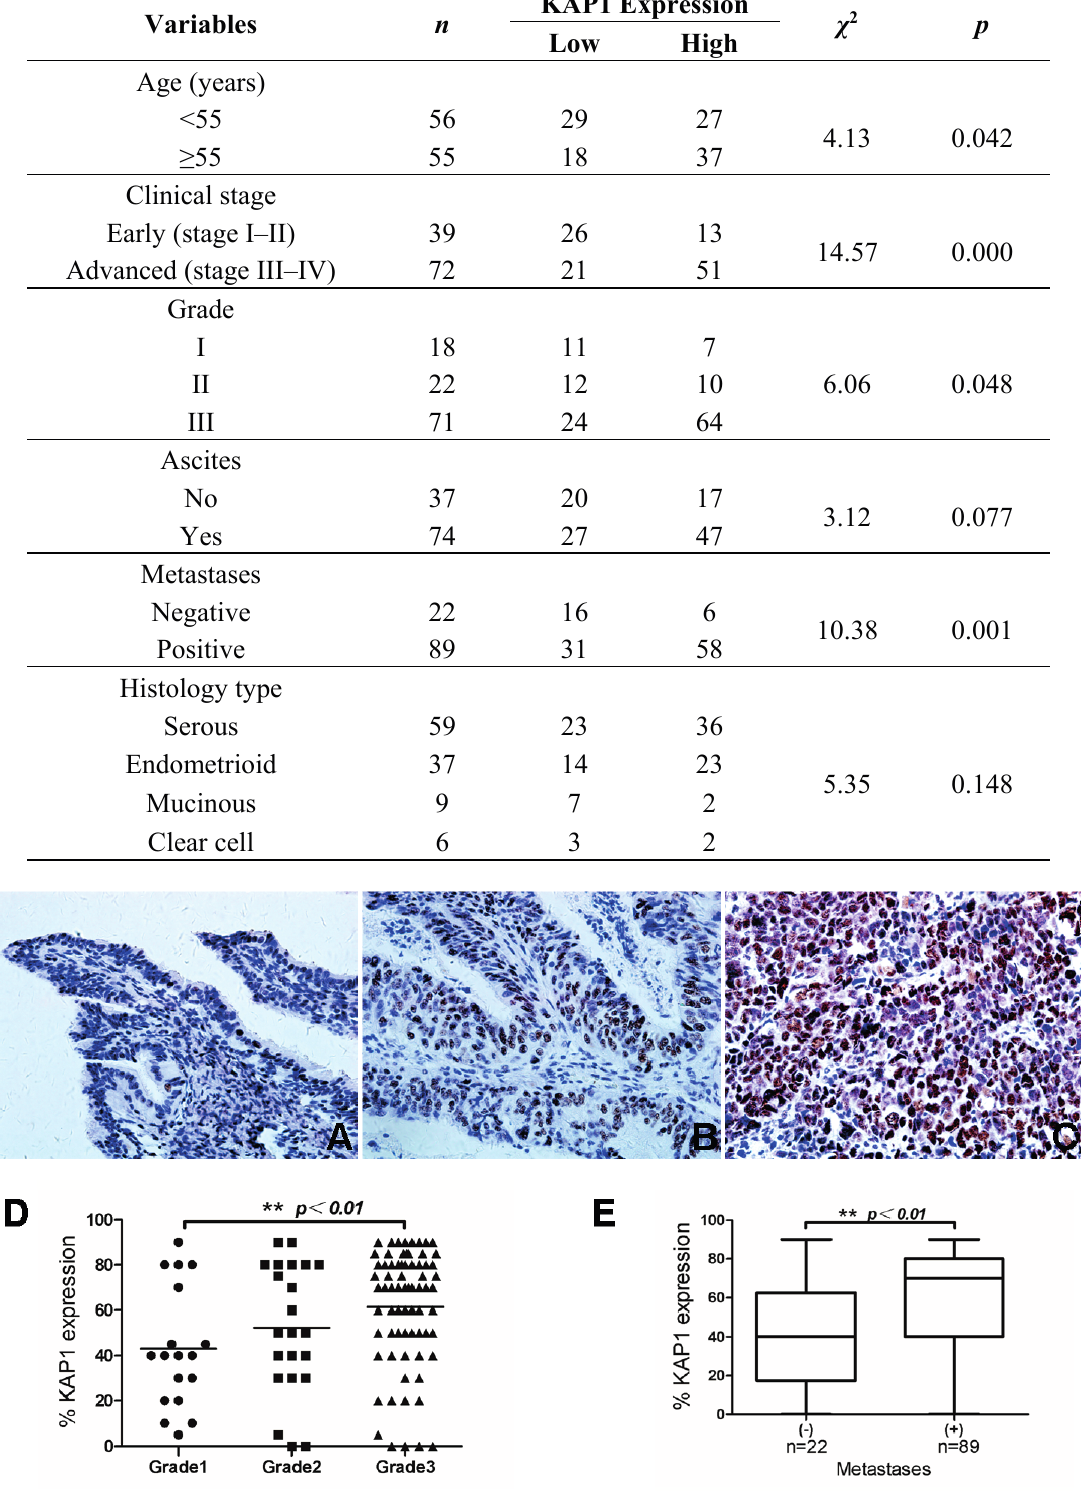
Figure 3. KAP1 expression levels in different pathological grade ( A ) grade 1; ( B ) grade 2; ( C ) grade 3; ( D ) Significant differences in KAP1 expression levels between grade 1 and grade 3 and ( E ) KAP1 expression levels in groups of different metastasis status. ( ** p <